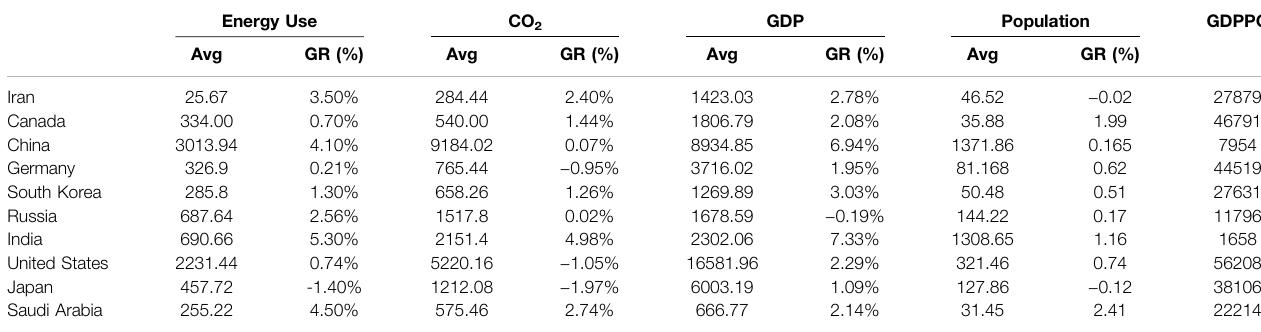
TABLE 3 | Values of descriptive